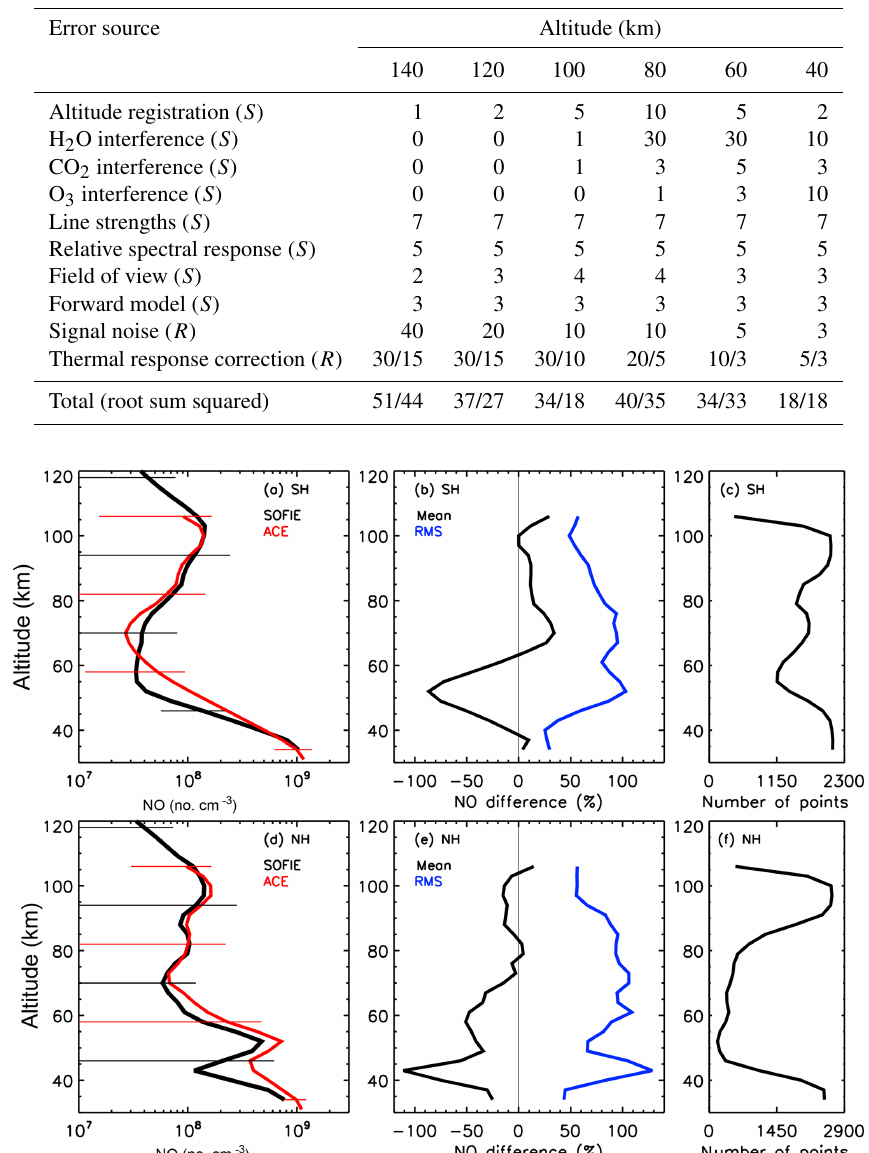
Table 1. Uncertainty (%) in retrieved NO number density versus altitude due to various random ( R ) and systematic ( S ) error mechanisms. Two values are listed when they were different for sunrise/sunset.